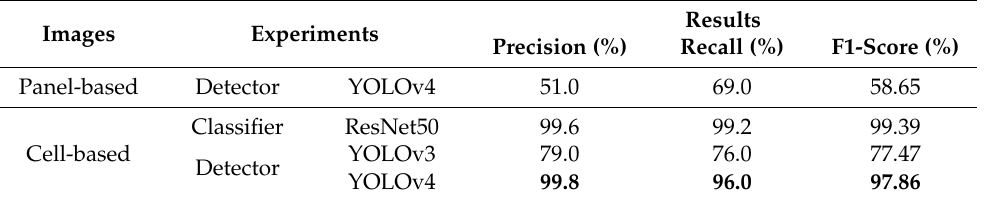
Table 6. SCDD Experimental